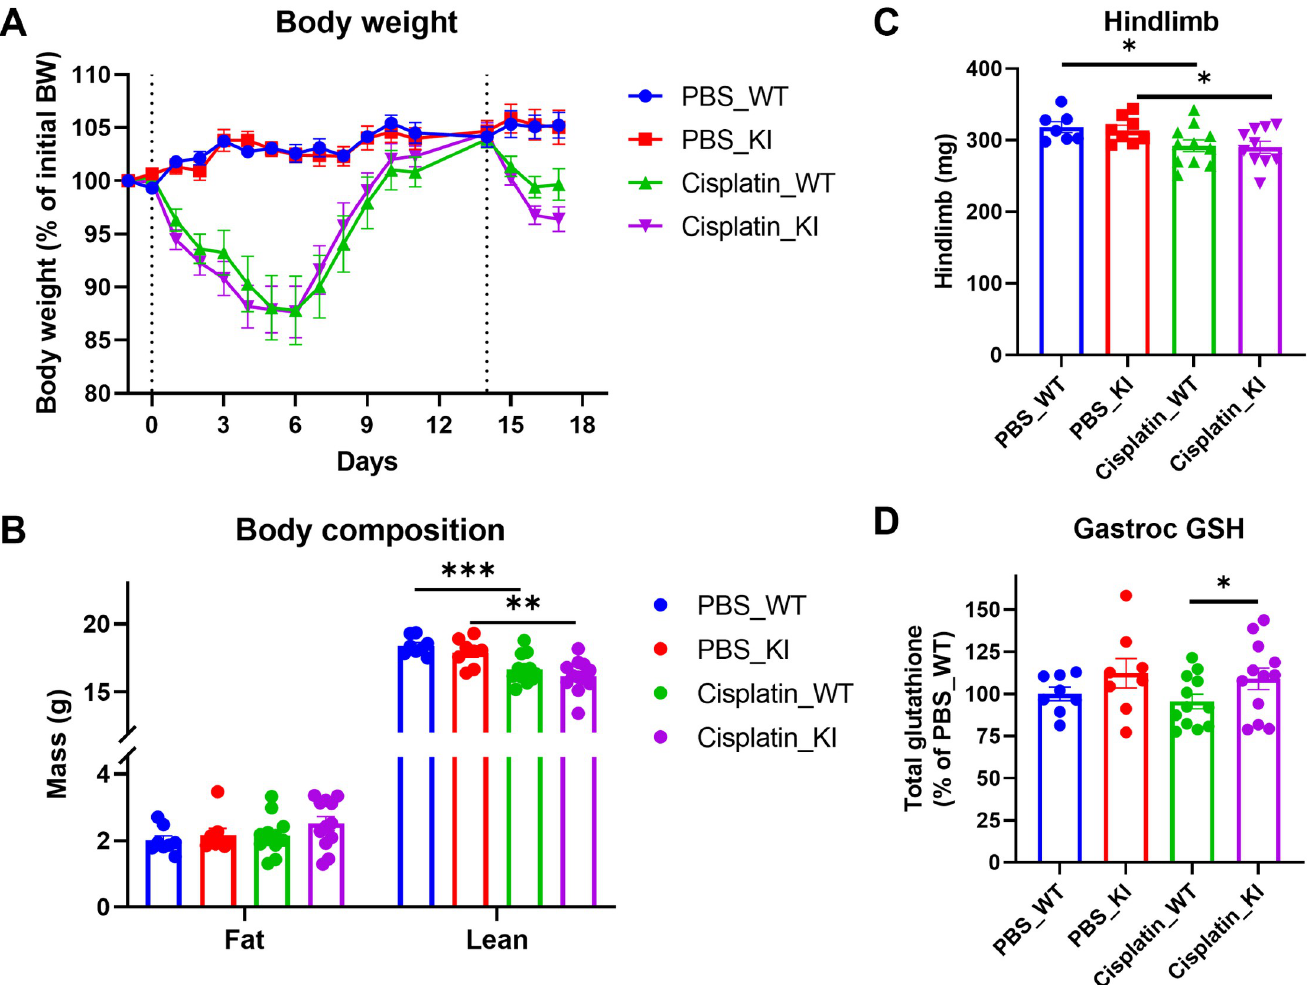
Fig 5. Chac1 inactivation preserves glutathione but does not protect against cisplatin induced muscle wasting. A. Curves of body weights normalized by initial body weights on day -1. B. Body compositions measured at the end of study. C. Weights of total hindlimb muscles, including gastrocnemius, TA, and quadriceps, measured at takedown. D. Total glutathione measured in gastrocnemius muscles. Results are shown as mean ± SEM with individual data plotted. Statistical significances were indicated as: * P < 0.05, ** P < 0.01, *** P < 0.001.